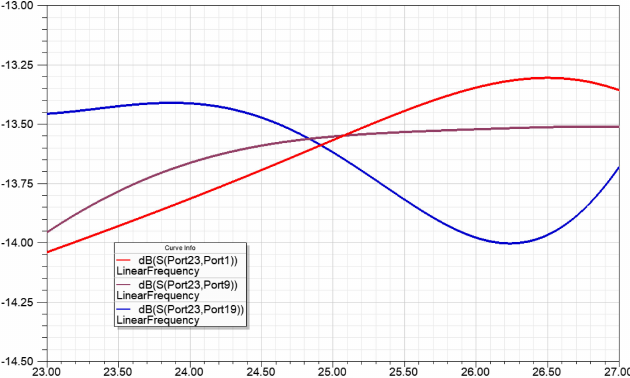
Figure 19. Power ratio for the radiators of the power division network for 1 to 2:10:10:2 power ratio, with ideal transmission lines.